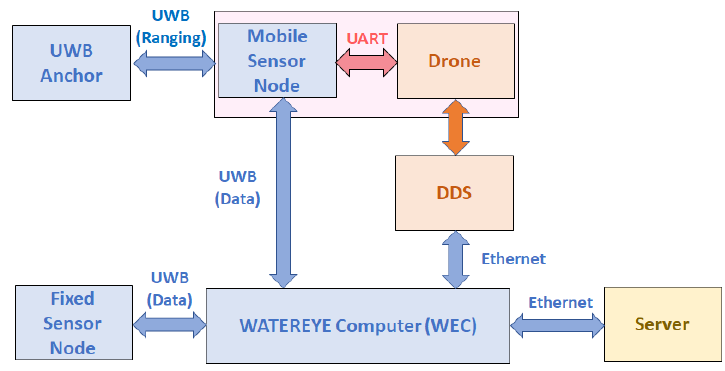
Figure 1. WATEREYE system architecture.